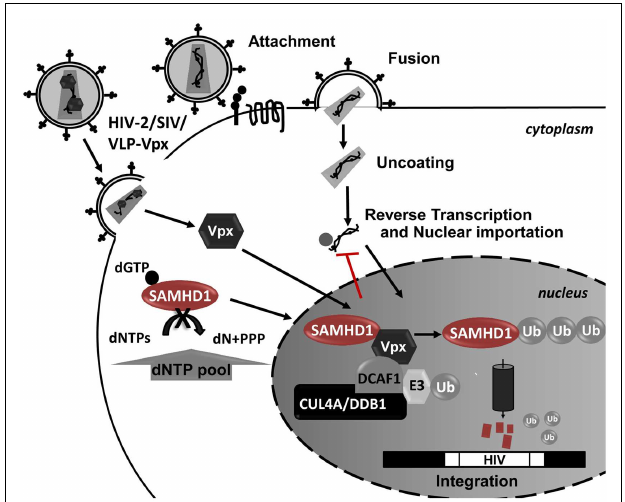
FIGURE 4 | Schematic representation of SAMHD1Vpx-mediated proteosomal degradation during HIV-1 infection . In the presence ofVpx, SAMHD1 is recruited to a CUL4-DDB1-DCAF1 protein complex in the nucleus, leading to the proteosomal degradation of SAMHD1.The SAMHD1 reduction leads to an increase in the dNTP pool allowing the HIV replication in these